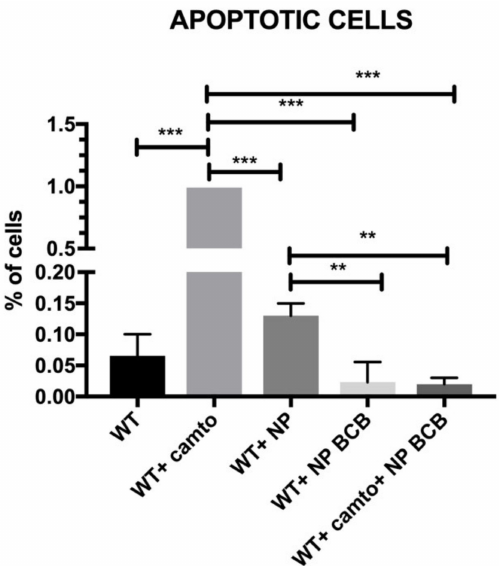
Figure 9. Apoptosis of examined SkMC populations, n =3. Abbreviations: WT—wildtype cells; WT campto—wildtype cells treated with camptothecin; NP—nanoparticles; NP BCB (bax channel blocker)—nanoparticles loaded with BCB. Statistical significance legend: p < 0.05 (*), p < 0.01 (**), p < 0.001 (***). Results were performed using a one-way